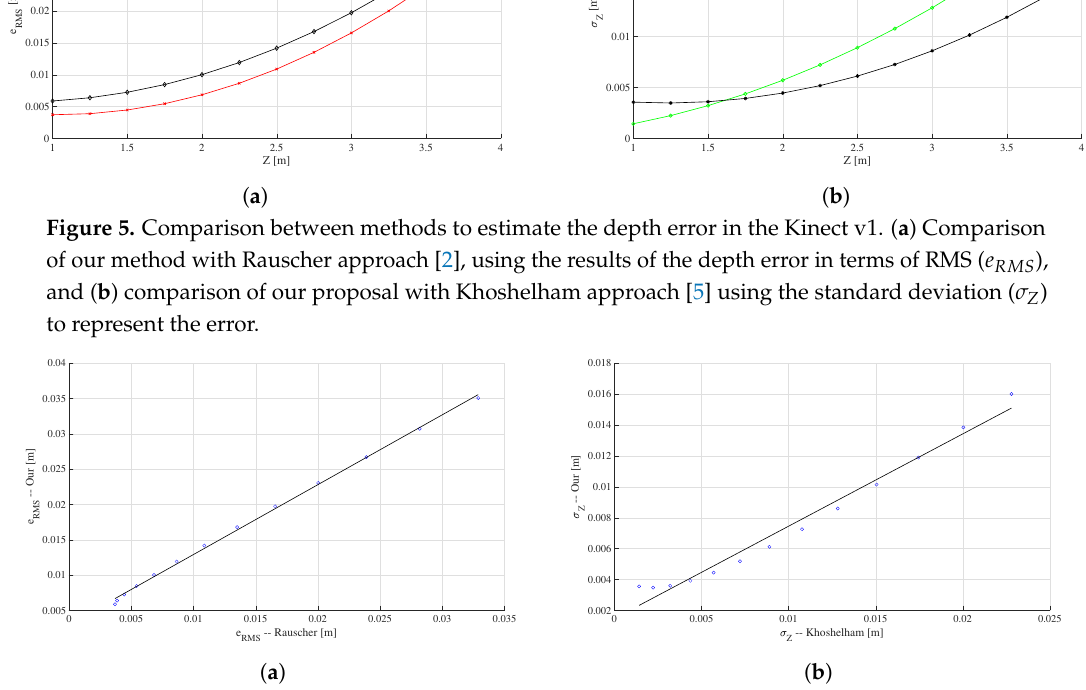
Figure 6. Dispersion graphs of Kinect v1 depth errors curves, ( a ) Rauscher et al. [2] vs. our RMS error ( e RMS ) and ( b ) Khoshelham and Elberink [5] vs. our standard deviation of the depth error ( σ Z